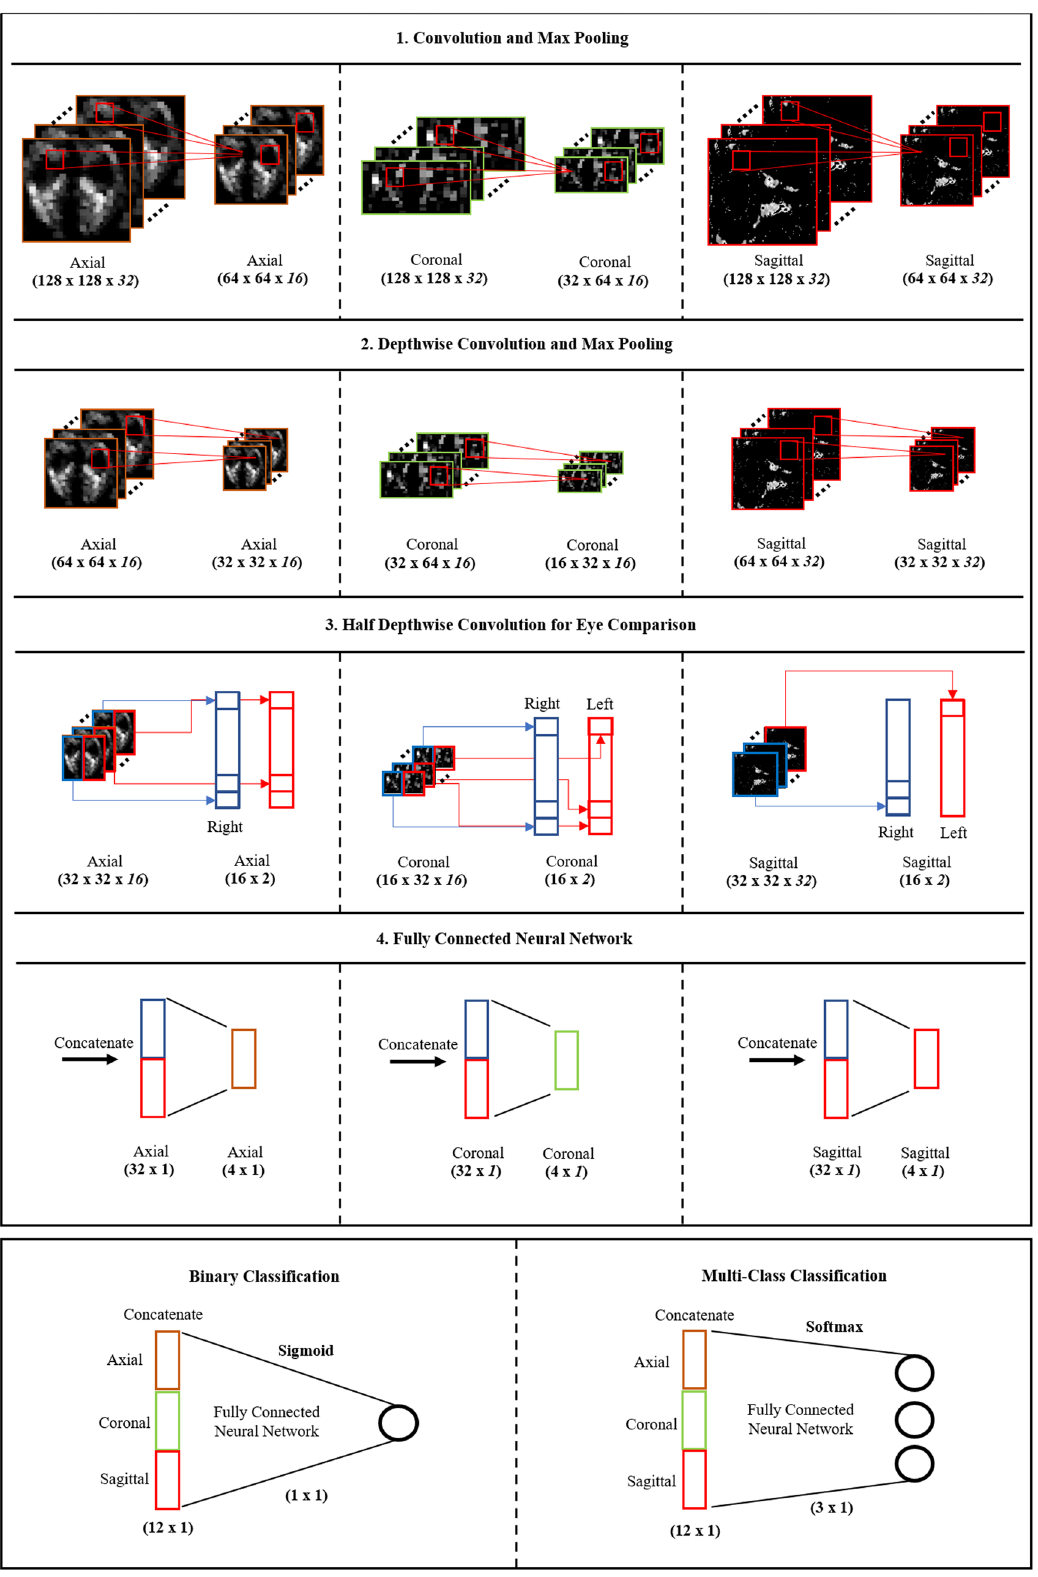
Figure 4. Overview of neural network modeling. The neural network consists of convolutional operators with a half depth-wise convolution layer for binocular comparison that reduces the number of parameters compared to that in a convolutional neural